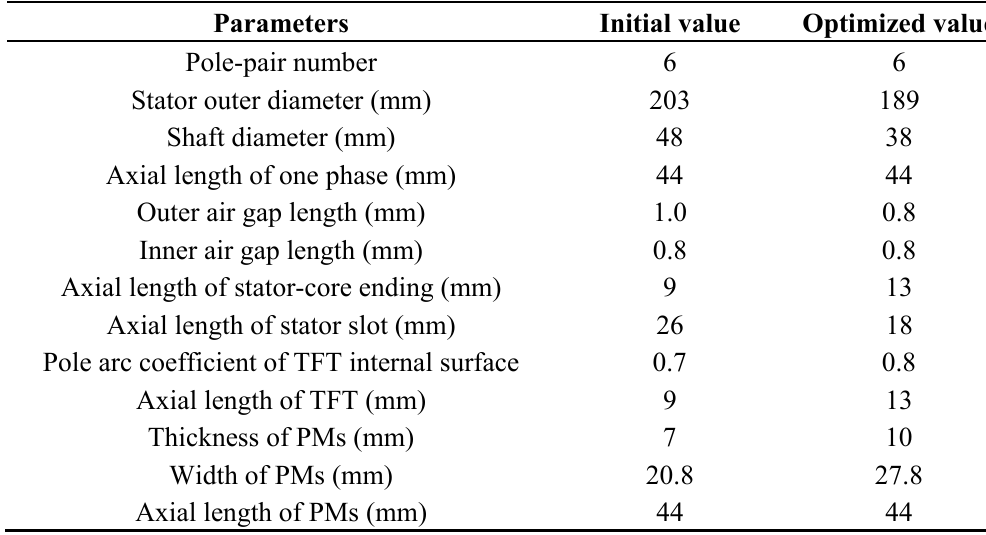
Table 1. Initial and Optimized Parameters of the